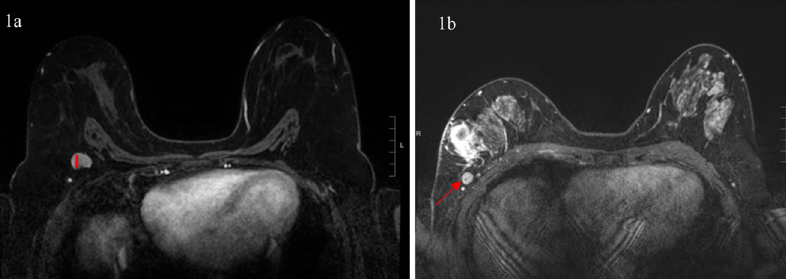
Fig. 1 Abnormal lymph node fi ndings on breast MRI. a , b Examples of lymph node abnormalities on breast MRI. a Left: shows increased cortical thickening ( ≥ 3 mm) of an axillary lymph node in the right axilla (red line). b Right: shows an example of an axillary lymph node with rounded morphology in the right axilla and asymmetry when compared to the contralateral axilla (red arrow).